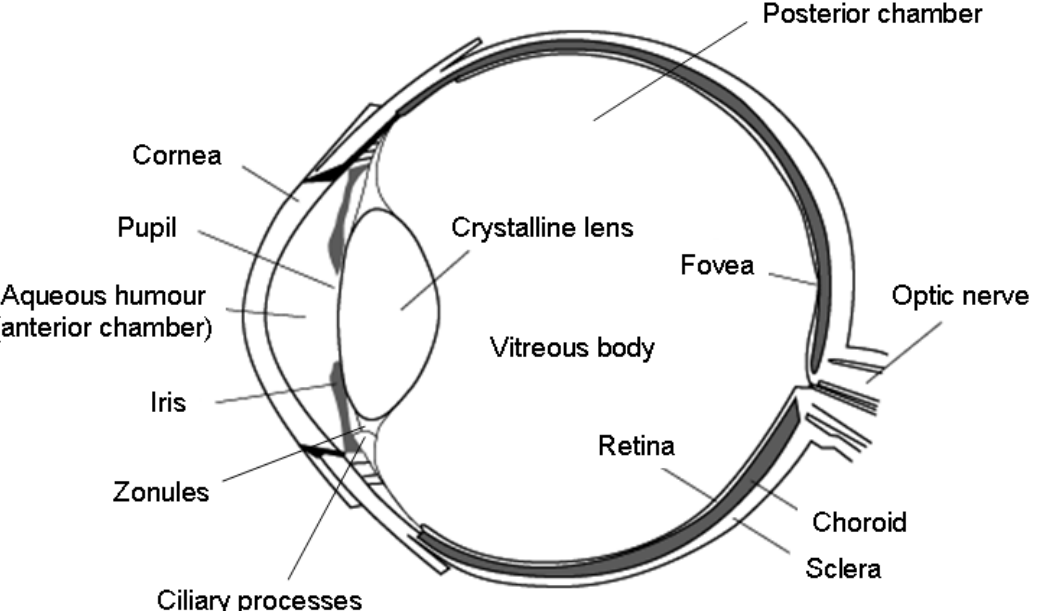
Figure 1. Schematic illustration of the eye anatomy. Reproduced from Reference [17]. Table 1. Components of the eye and their functions.